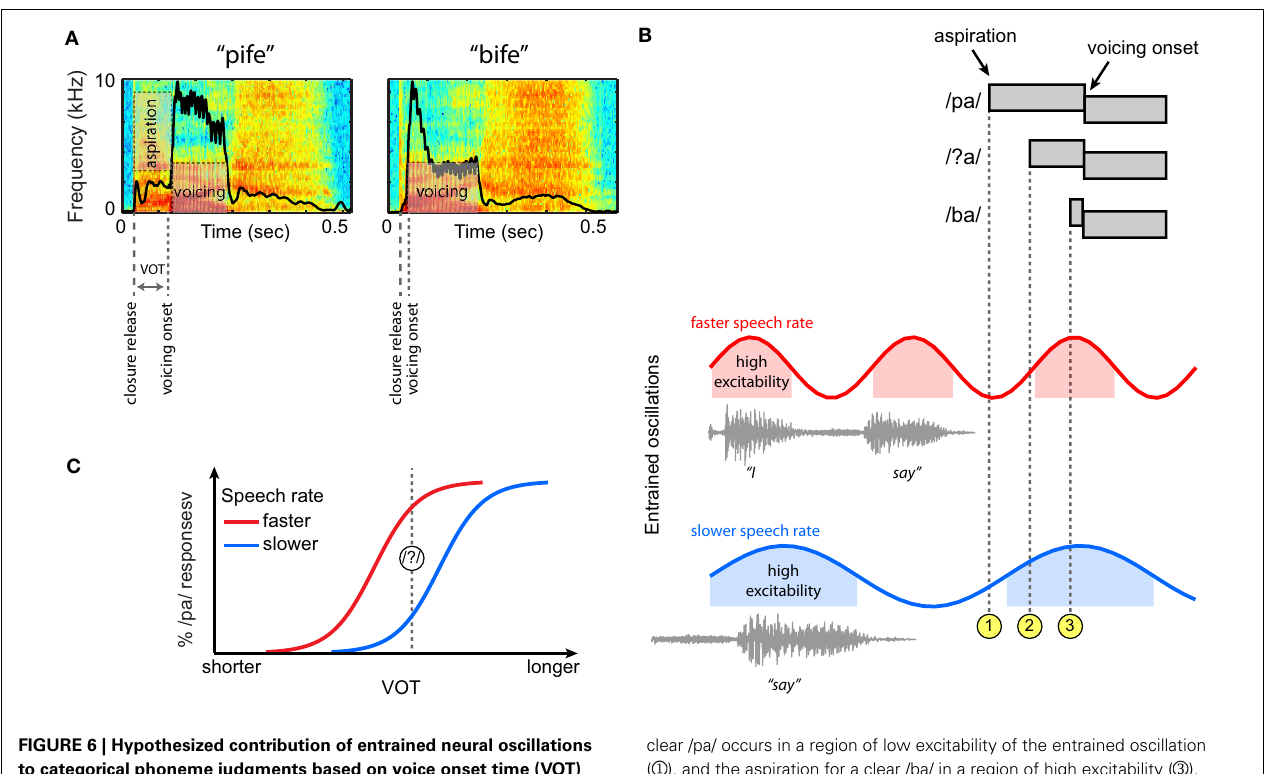
FIGURE 6 | Hypothesized contribution of entrained neural oscillations to categorical phoneme judgments based on voice onset time (VOT) in connected speech. (A) Spectrograms of two non-words, “pife” and “bife.”The amplitude envelope for each is overlaid in black. (B) At top, schematic illustrations of three phonetic tokens (/pa/, /ba/, and an ambiguous intermediate token, /?a/) that differ inVOT. Neural oscillations entrained to two different speech rates are shown below, here for the short carrier phrase “I say ____.” For both speech rates, the aspiration for a